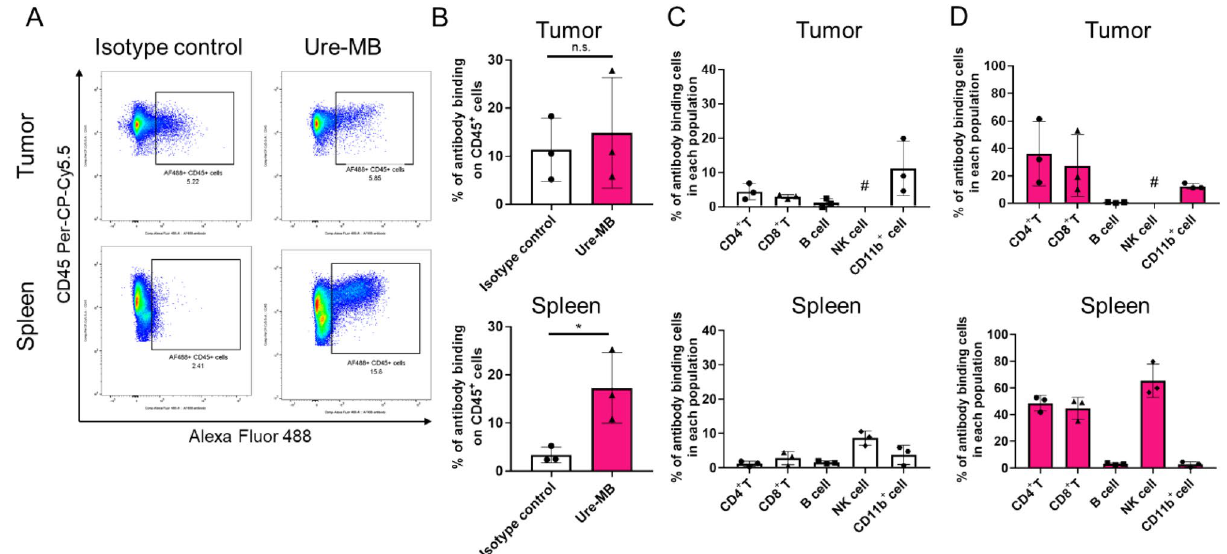
Figure 3. Anti-human CD137 antibody-binding cells in LLC1/OVA/hGPC3-bearing hCD137-KI mice. An Alexa Fluor 488-labeled isotype control antibody or Ure-MB was administered twice at a dose of 1 mg/ kg. The tissues were sampled the day after the second administration. ( A ) Representative data plot of Alexa Fluor 488-labeled antibody-binding CD45 + cells in tissues. The population in the square represents Alexa Fluor 488-positive cells. ( B ) Percentage of Alexa Fluor 488-labeled antibody-binding CD45 + cells. Alexa Fluor 488-positive cells were detected in each tissue. The data were collected from three mice in each group. *p < 0.05 by t test. ( C,D ): ( C ) Alexa Fluor 488-labeled isotype control antibody binding and ( D ) Alexa Fluor 488-labeled Ure-MB binding for each type of cell in the tumor and spleen. The percentage of Alexa Fluor 488-positive cells for each cell type was calculated by flow cytometry. #NK cells in tumors were not detected in this experiment.